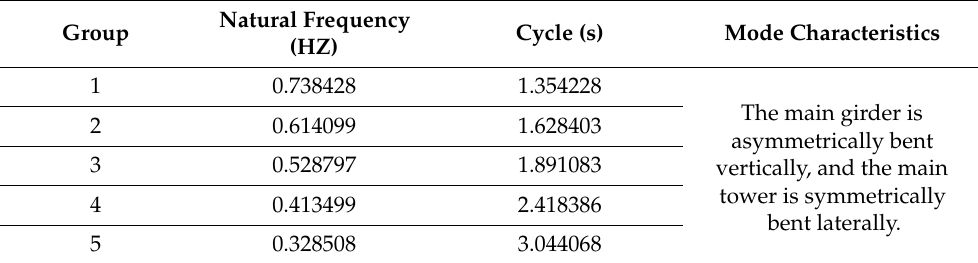
Table 10. Natural frequency and corresponding vibration mode